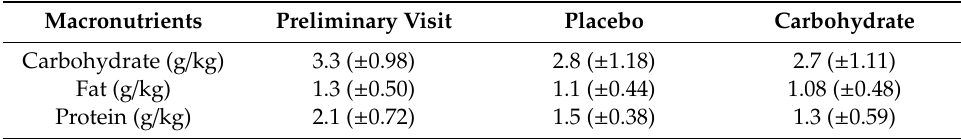
Table 1. Mean ( ± SD) macronutrient intake for all participants between the testing conditions.